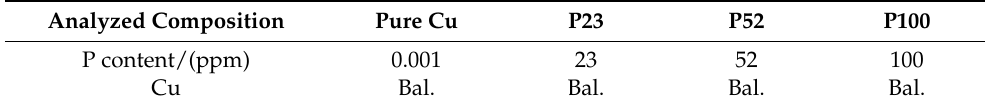
Figure 1. The processing steps of specimens. Table 1. Chemical compositions of the